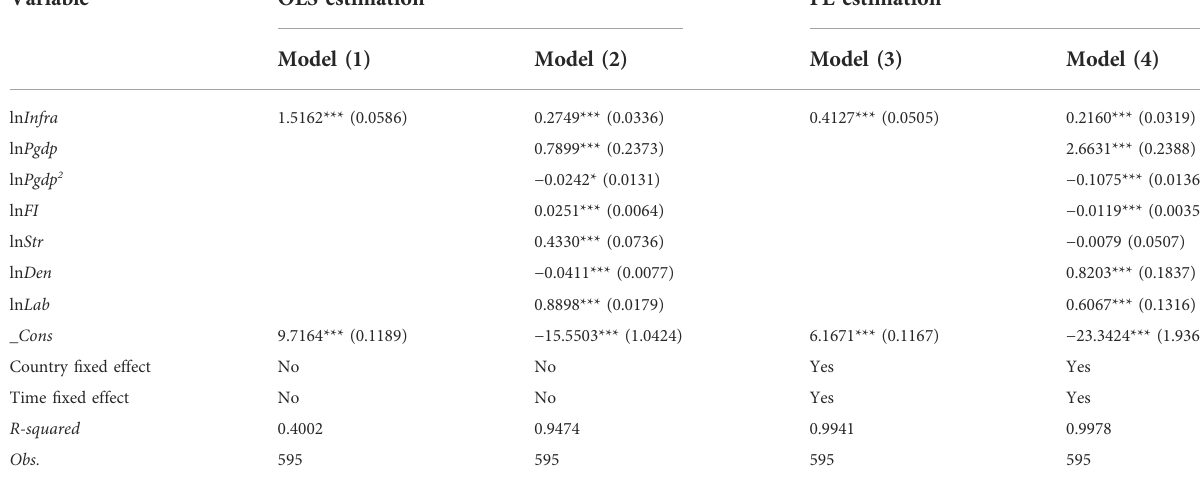
TABLE 3 Results of the benchmark regression.